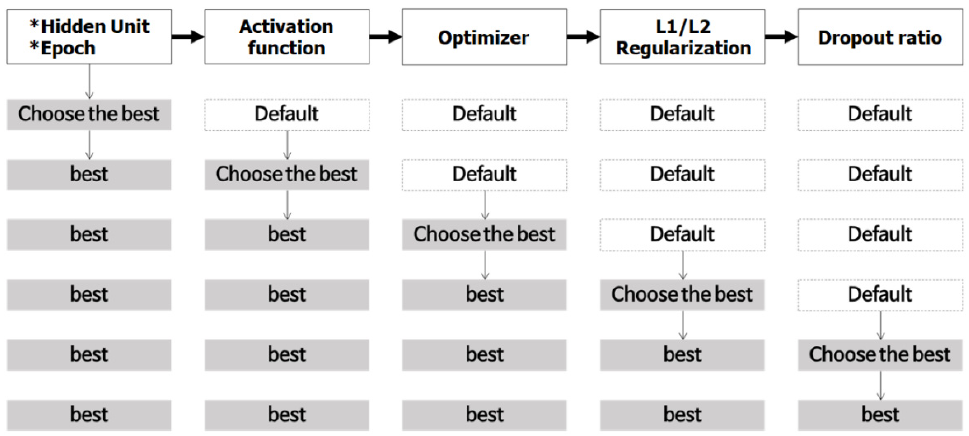
Figure 3. The parameter optimization process for a deep neural network (DNN) model in this study, which was adopted from [46]. L1—regularization uses the Manhattan norm; L2—regularization uses the Euclidean norm, for the adjustment of weights.